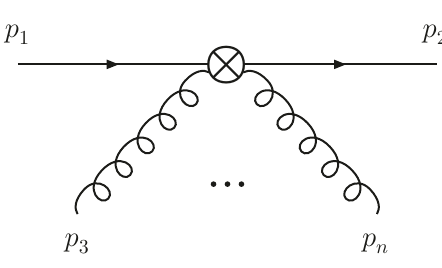
in perturbative f (cid:22) 1 ;:::;(cid:22) N g